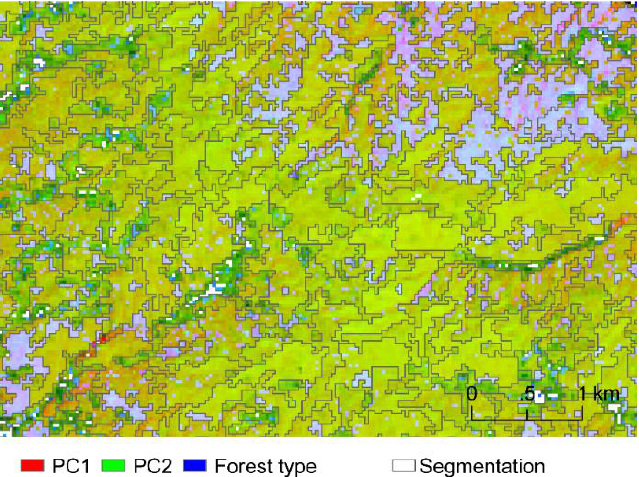
Figure 10. A piece of the composited layer of the first principal component (PC1), the second principal component (PC2), and the forest type. We performed multi-resolution segmentation, based on the composited layer.